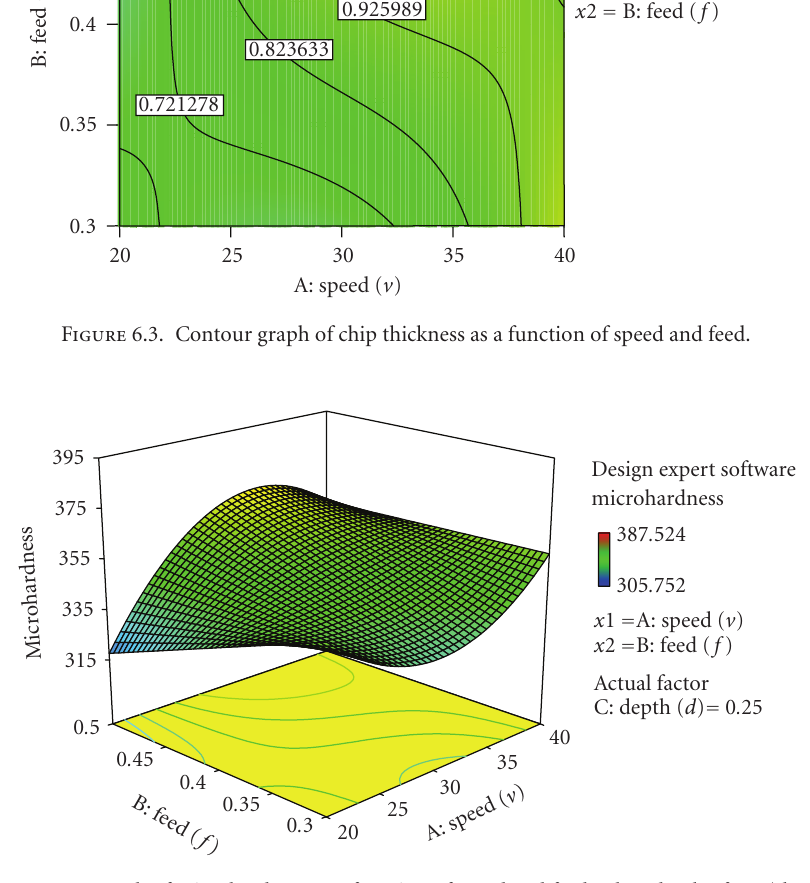
Figure 6.4 . 3D graph of microhardness as a function of speed and feed at low depth of cut ( d =